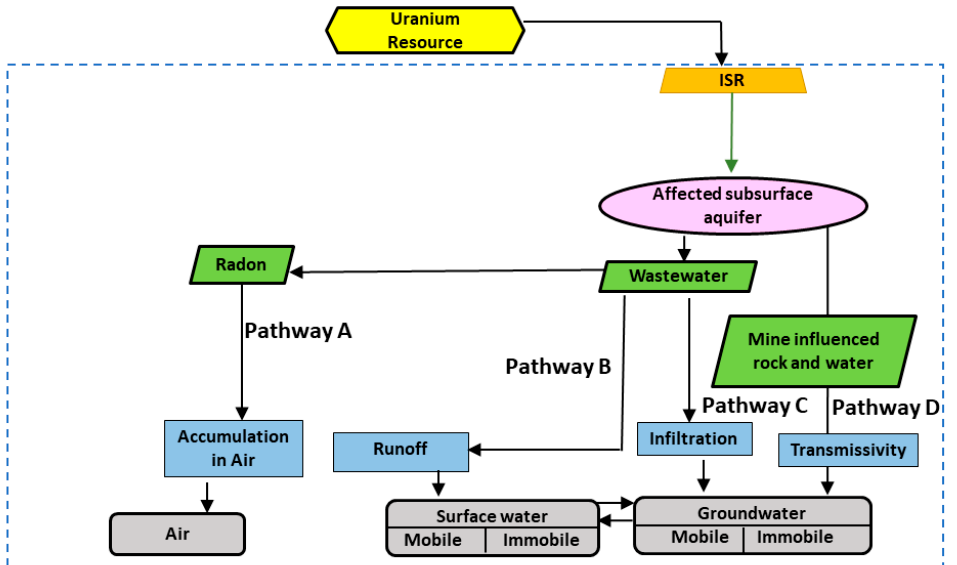
Figure 3. Conceptual source-to-receptor model for in situ uranium recovery (ISR) of undiscovered uranium resources in the Goliad Sand, Willis Formation, and Lissie Formation and alluvial sediments in the Texas Coastal Plain. Pathways are not listed in any specific order or importance.